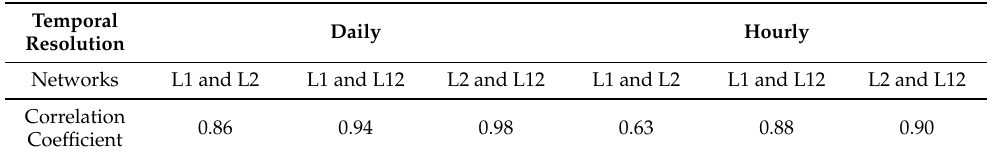
Table 6. Correlation coefficient of the dUT1 estimates from legacy networks for daily and hourly